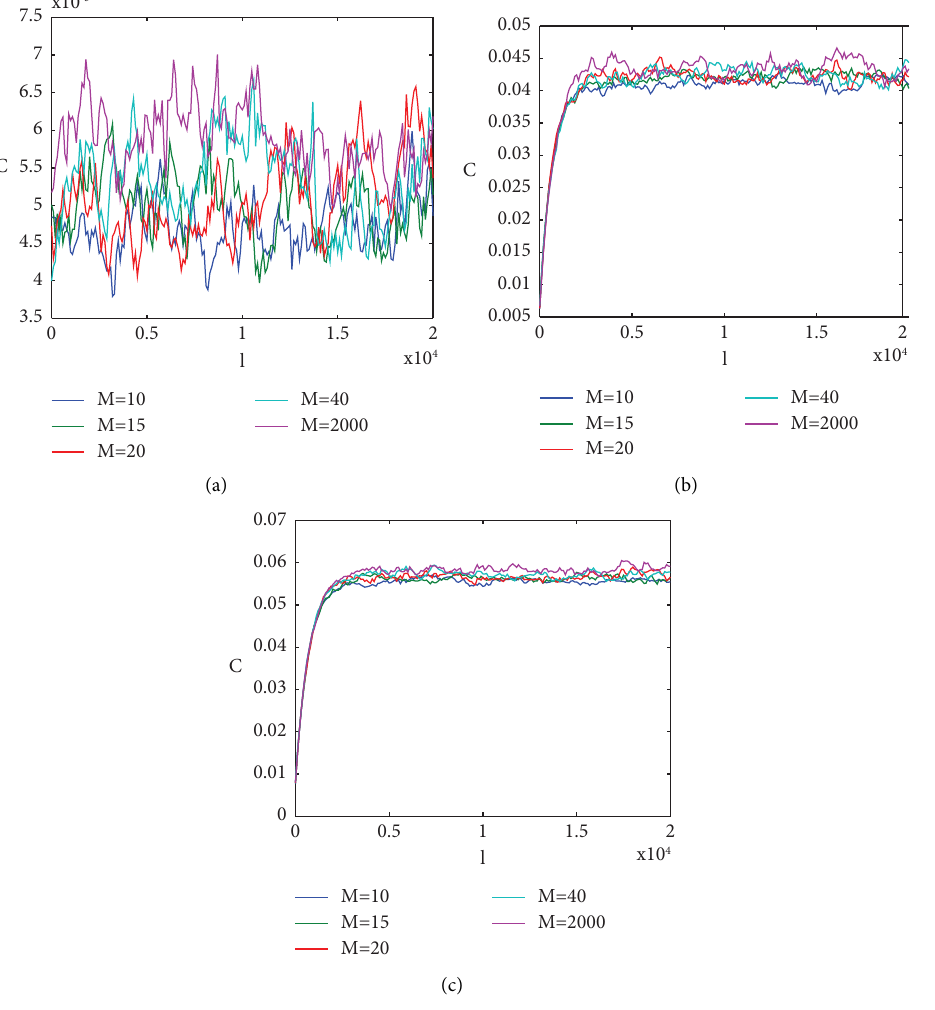
Figure 4: Clustering coefcients of the network during the evolution of the network for diferent values of M . Te network evolves as the generating algorithm in Section 3.1, where the initial network has a Poisson degree distribution with mean m ( p + 1 ) . Te parameters are m � 10, (a) p � 0, (b) p � 0 . 3, and (c) p � 0 .